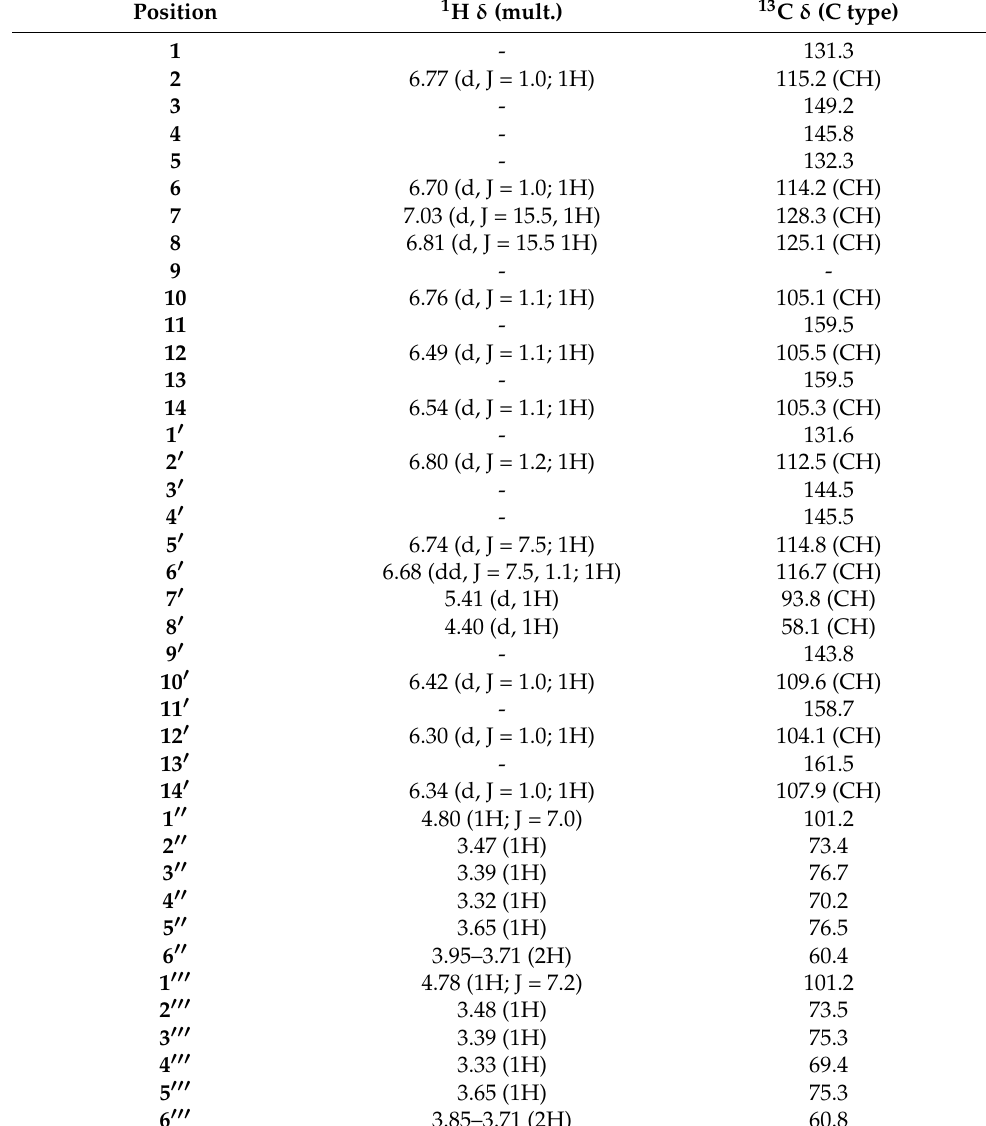
Table 2. 1 H and 13 C NMR data of compound 13 .